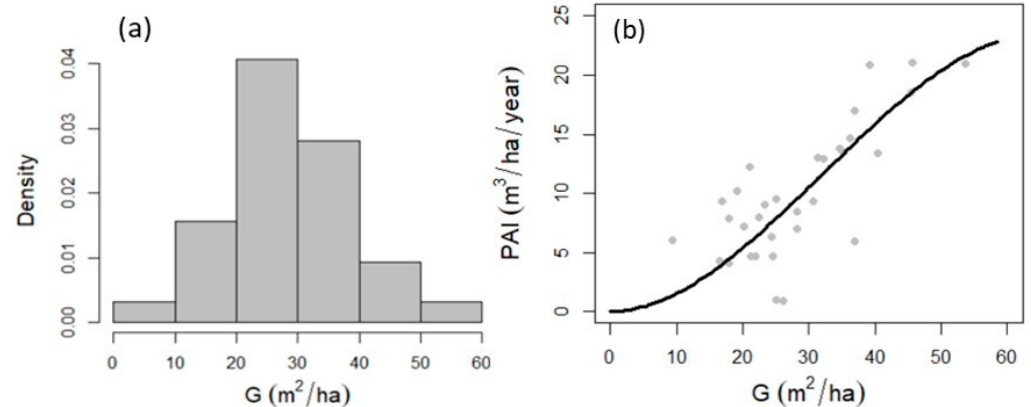
Figure 6. Distribution of forest densities in our field plots and the density-production relation for Group 1. ( a ) Distribution of basal area; ( b ) relation between basal area and production.